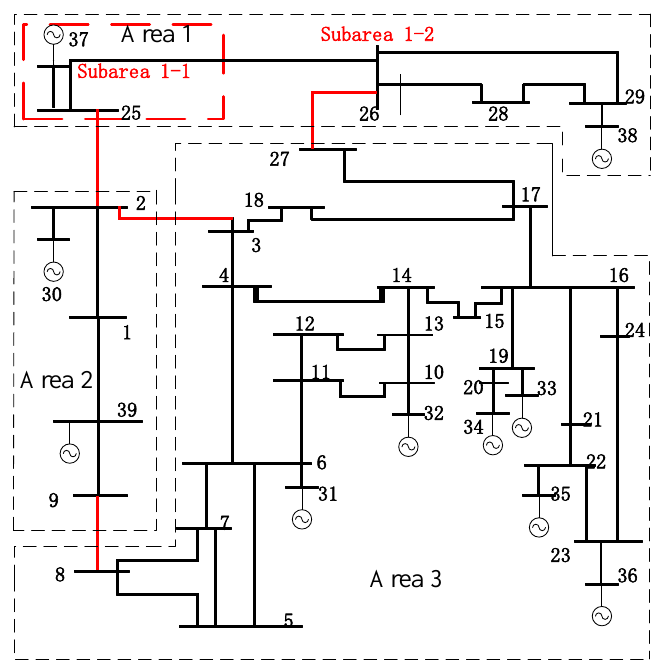
Figure 10. Diagram of an IEEE 39 system based three-area ring